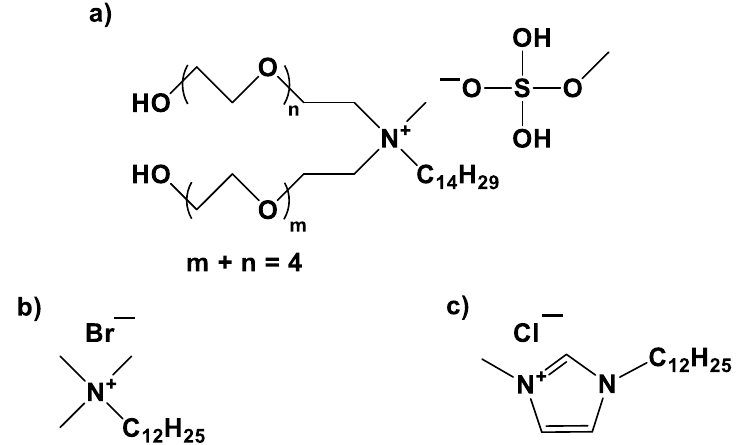
Figure 1. Molecular structures of ( a ) IL IOLILYTE C1EG, ( b ) DTAB, and ( c ) IL